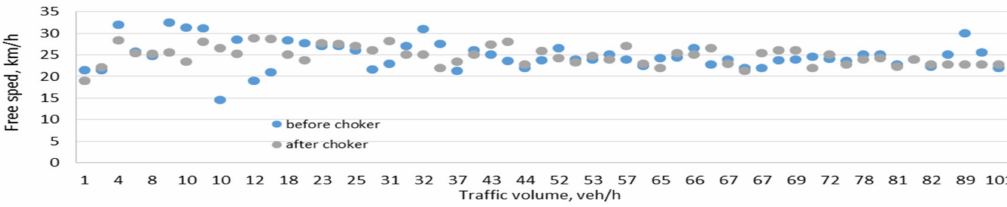
Figure 16. Summary of 85th percentile free-flow speed changes depending on hourly traffic (testing ground No. 2). Source: own work of the author.